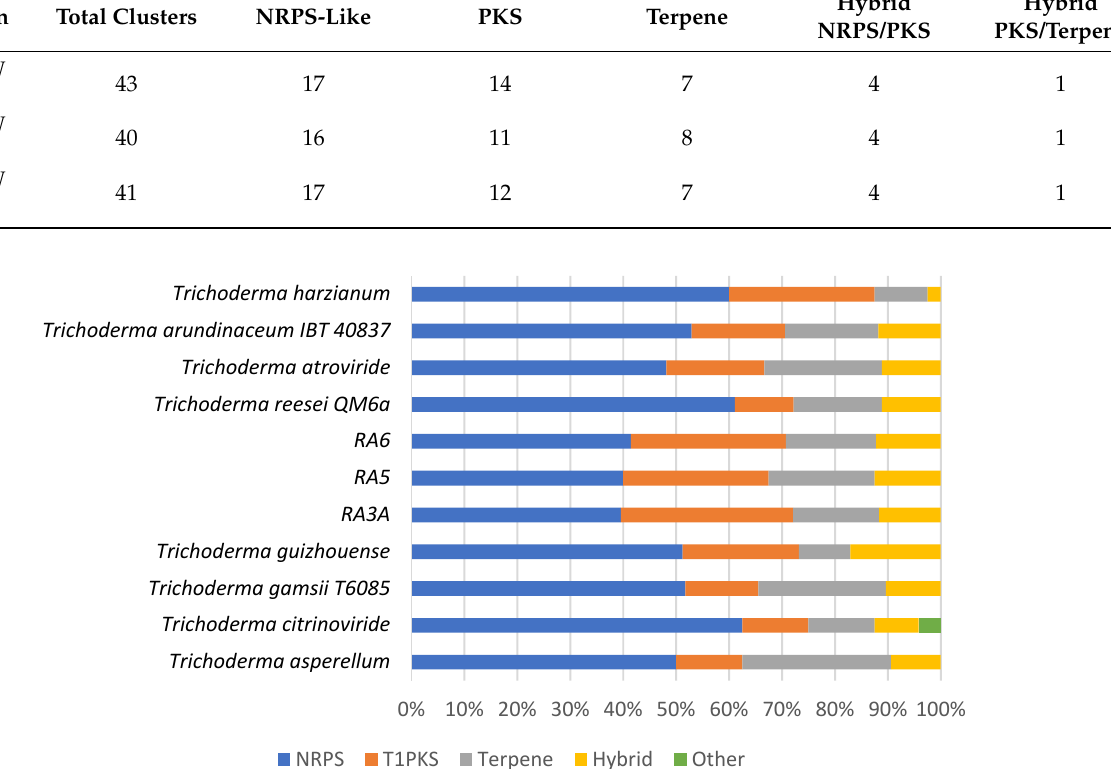
Figure 7. Comparison of the BGCs found in the genomes of the fungal strains RA3a, RA5, and RA6 with other members of the Trichoderma genus. BGC prediction was performed through AntiSMASH.